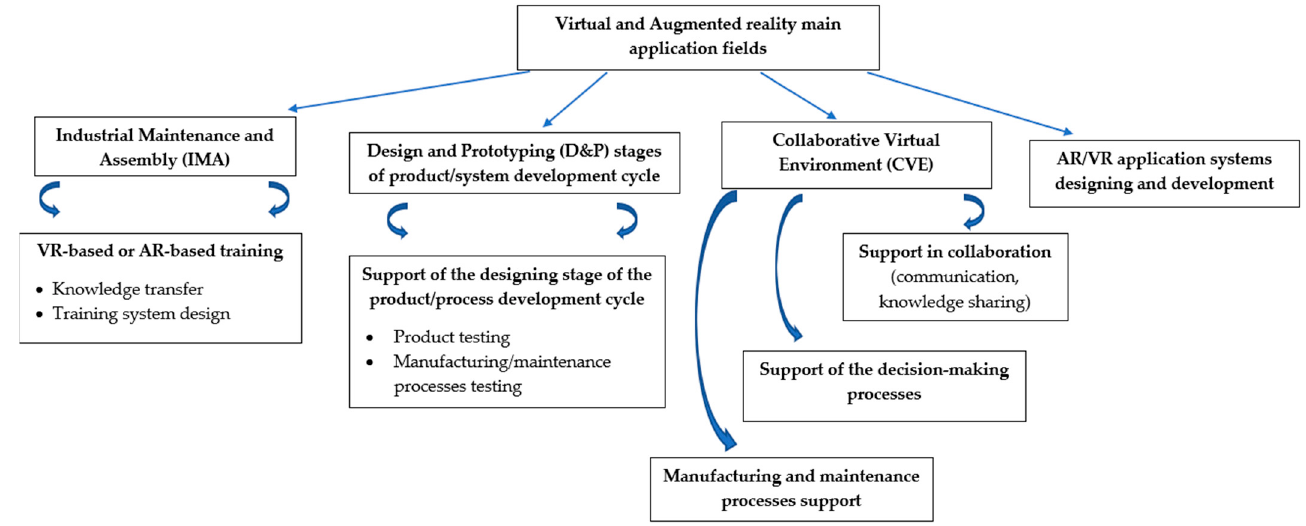
Figure 26. Virtual and Augmented reality main application fields. Source: own contribution.